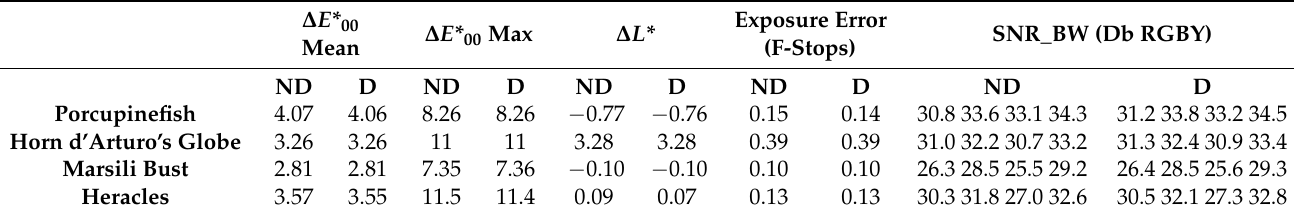
Table 7. Denoise efficiency report of means values of each dataset. ND = image no denoised; D = image denoised.